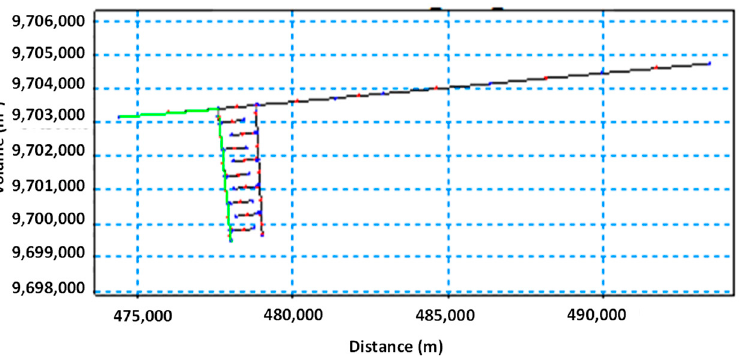
Figure 9. Schematic diagram of channel models for sediment movement in RC with sluicegate on